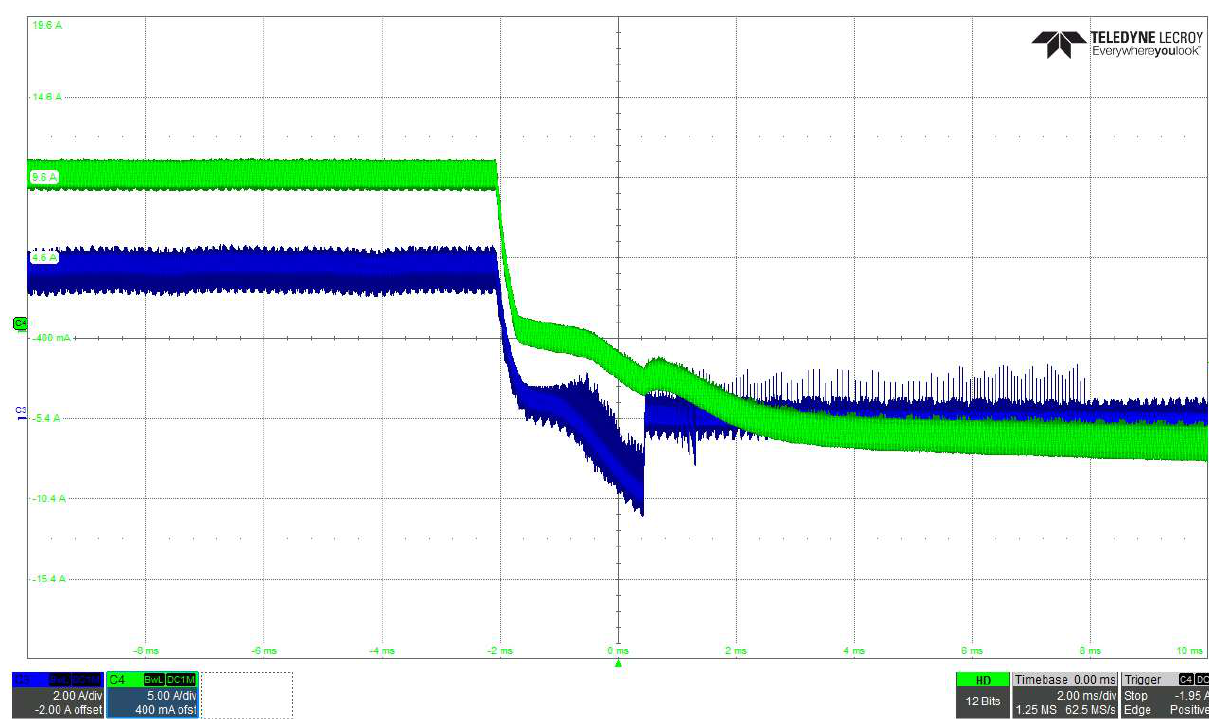
Figure 29. Experimental BHSC waveforms. Transition from step-up operation at −10 A to step-down operation at +10 A. Operating conditions: V H = 100 V, V L = 50 V, I L1 = (+/−)10A (controlled), I L2 = 3.75A. C3: i L2 ; C4: i L1 .